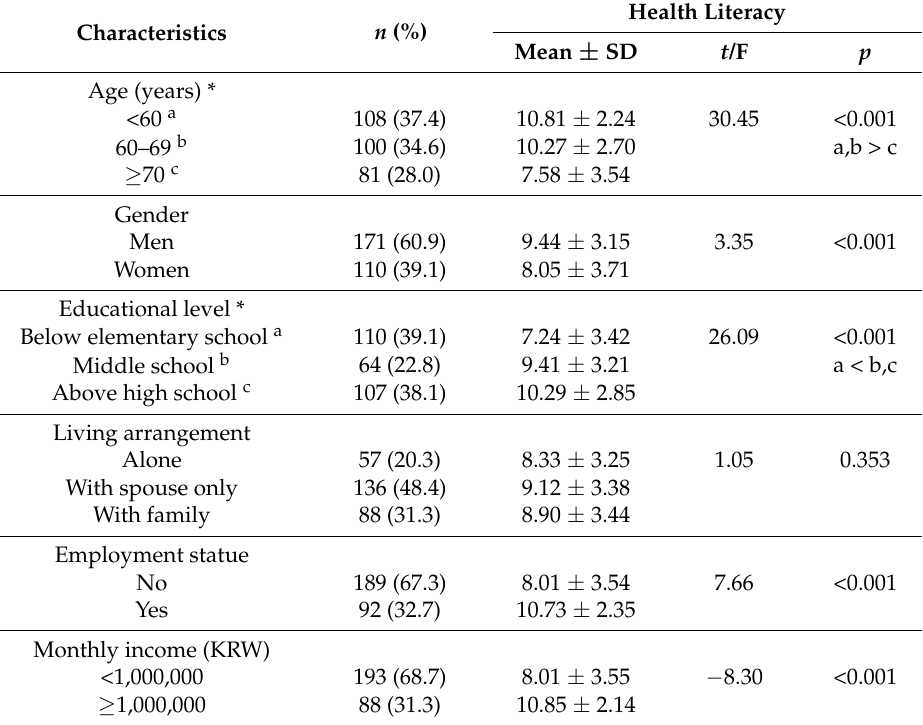
Table 1. Patients’ socio-demographic characteristics and differences in health literacy ( n =